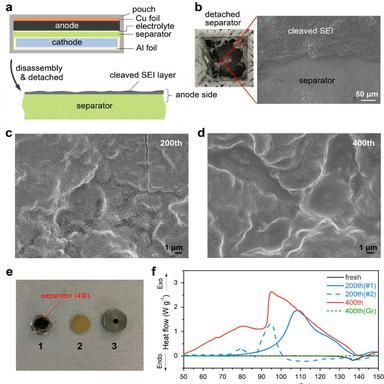
Schematic illustration of the cell structure and detachment step of the separator (a), digital image of the separator containing a cleaved SEI and the top-view SEM image corresponding to the region highlighted by the red square (b), high-magnification SEM images of the separator surface detached from the cycled cells (200th (c) and 400th (d)), DSC sampling image (e), where a detached separator is loaded into a stainless steel pan holder (assembly of 1 and 3) using a gold-plated copper seal (2), and the resu